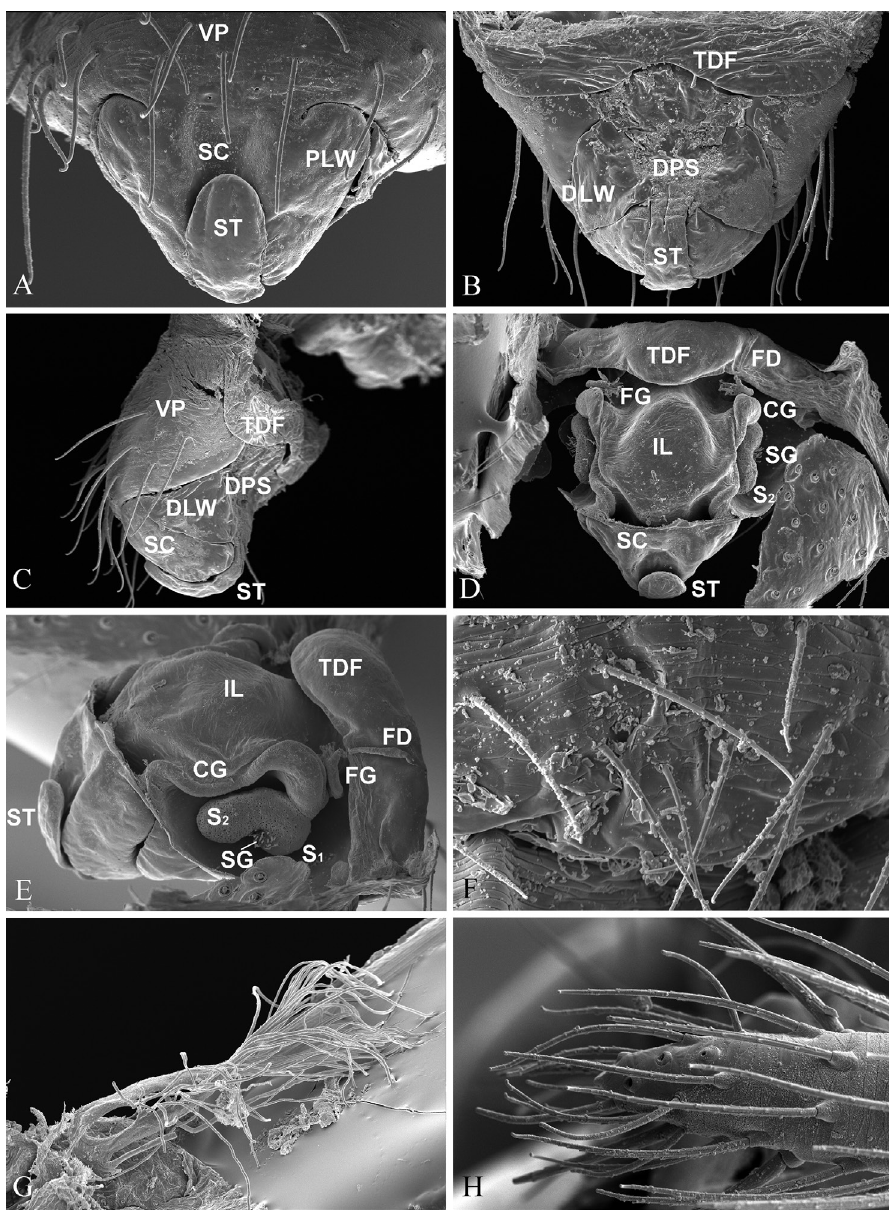
Figure 4. Nippononeta alpina comb. n. ( A–E ) epigynum A ventral B dorsal C lateral D ventral, cleared with ventral plate removed E lateral, cleared with ventral plate removed F male abdomen, ventral, shows epiandrous gland spigots absent G tracheal system, cleared H female palp, shows distal claw absent. Ab- breviations: CG copulatory groove; DLW lateral wing on distal part of scape; DPS distal part of scape; FG fertilization groove; IL inner lobe; PLW lateral wing on proximal part of scape; S spermatheca; S lower chamber of spermatheca; SC scape; SG special gland; ST stretcher; TDF transversal 2 dorsal fold; VP ventral